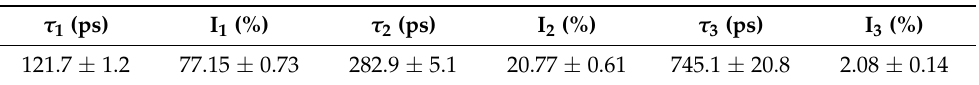
Table 1. Lifetime and intensity parameters that provide the best fit to the single crystal copper lifetime spectrum. The reduced- χ 2 parameter for this fit was